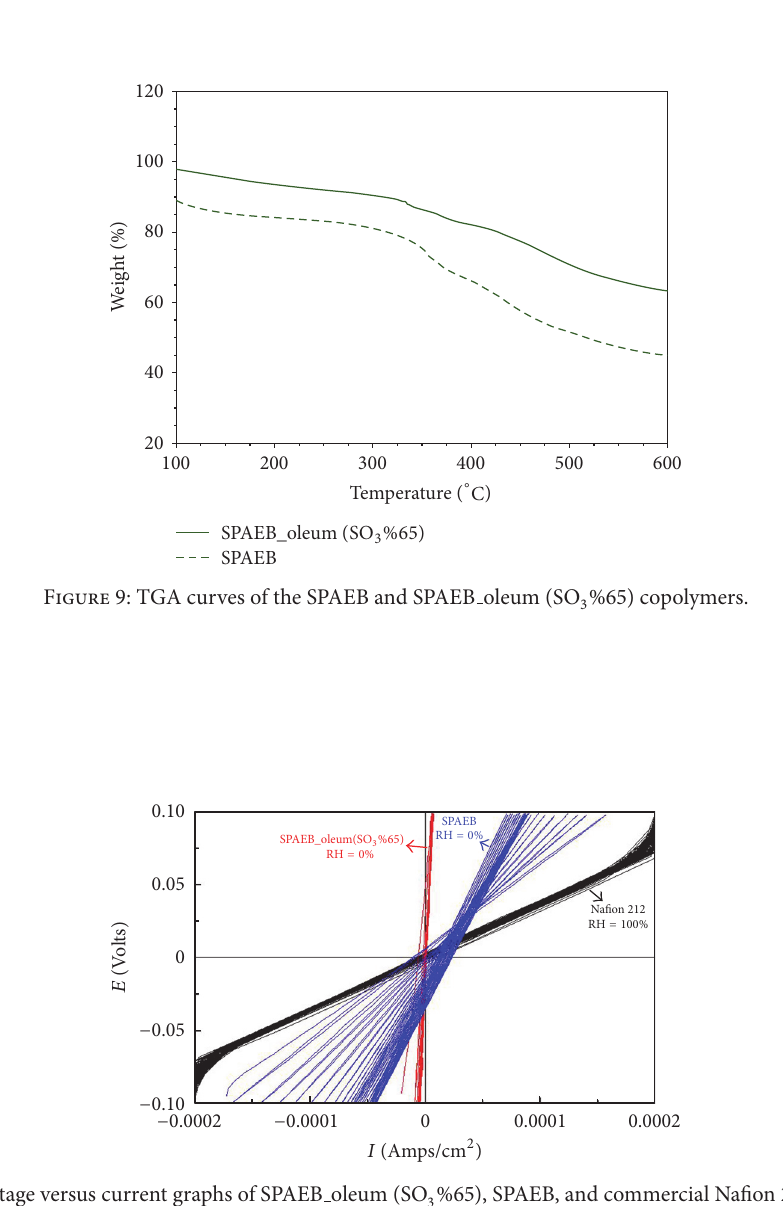
Figure 10: Voltage versus current graphs of SPAEB oleum (SO 3 %65), SPAEB, and commercial Nafion 212